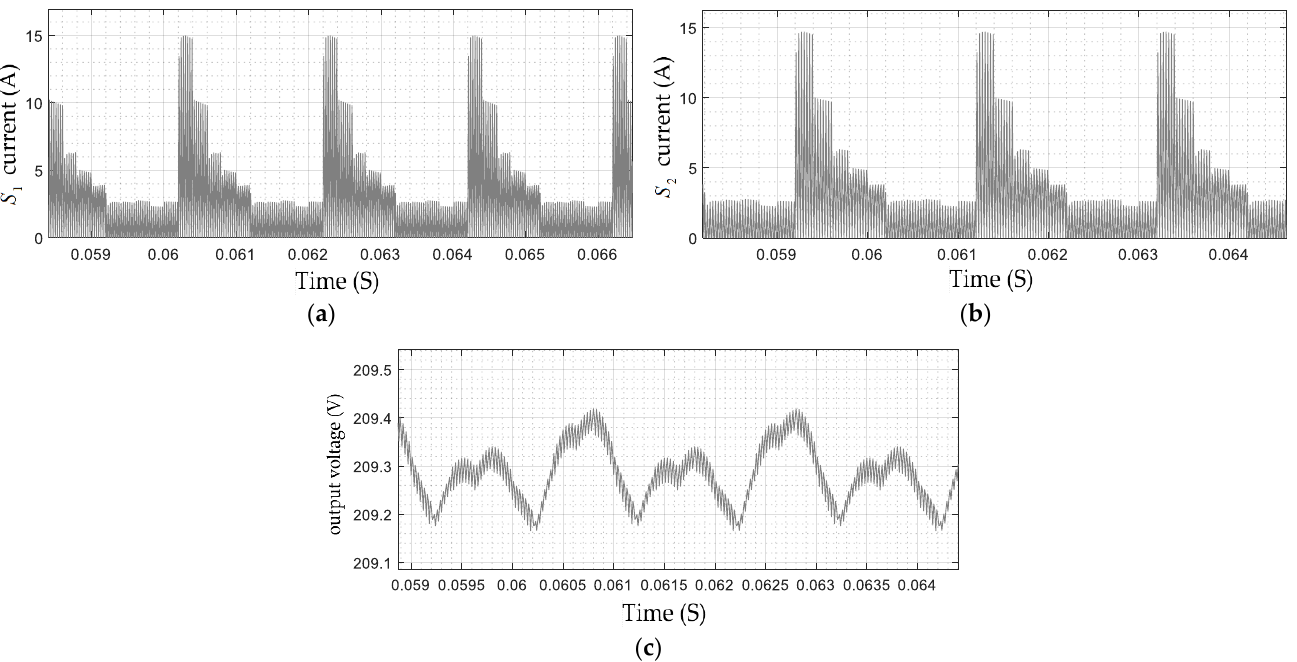
S current, ( b ) S current, and ( c ) output voltage. Figure 8. The results in critical mode, ( a ) S 1 current, ( b ) S 2 current, and ( c ) output 1 2